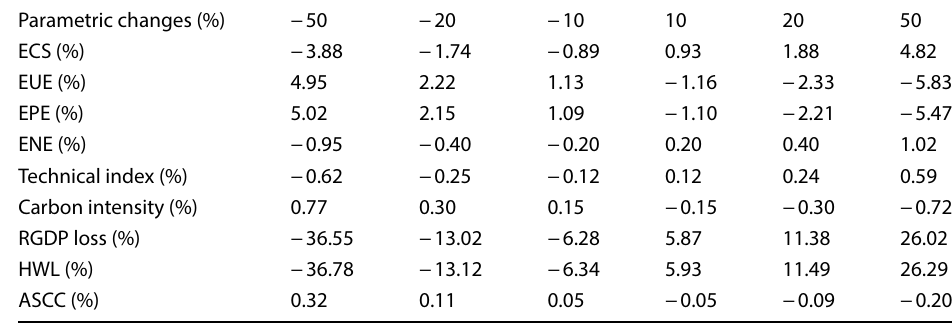
Fig. 10 The ECS in the baseline and tax scenarios. 0% is the baseline scenario; 1%, 2%, and 3% refer to the 1%, 2%, and 3% tax scenarios respectively